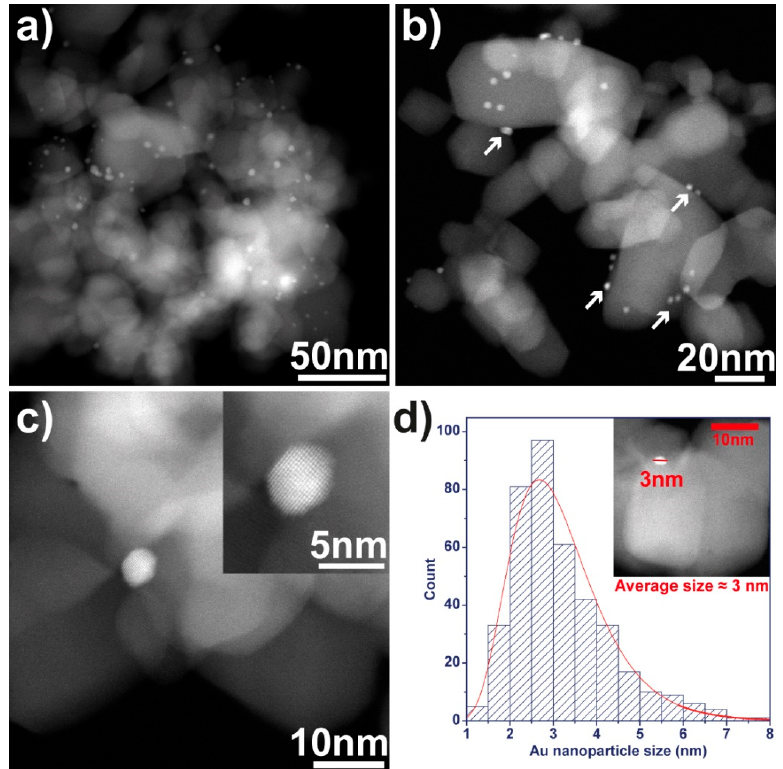
Figure 2. STEM-HAADF micrographs of Au/TiO 2 nanocomposites (produced at 60 °C and Au loading of 0.05 wt. %) at different scales ( a ) 50 and ( b ) 200 nm; detail of Au nanoparticle over TiO 2 nanoparticles’ surface and single Au nanoparticle amplification (inset) ( c ); size distribution of 400 Au nanoparticles with the respective average size ( d